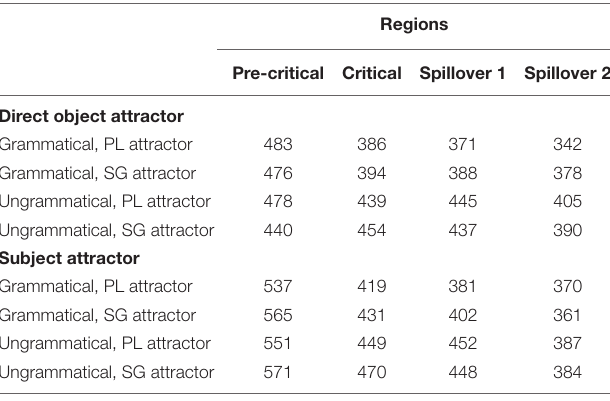
TABLE 5 | Mean reading times (ms) by condition at the regions of interest for Experiment 2.